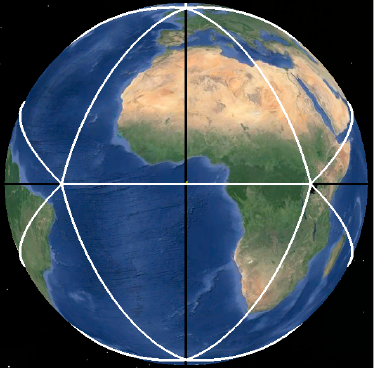
Figure 7. Base system spherical icosahedron oriented for octant symmetry.